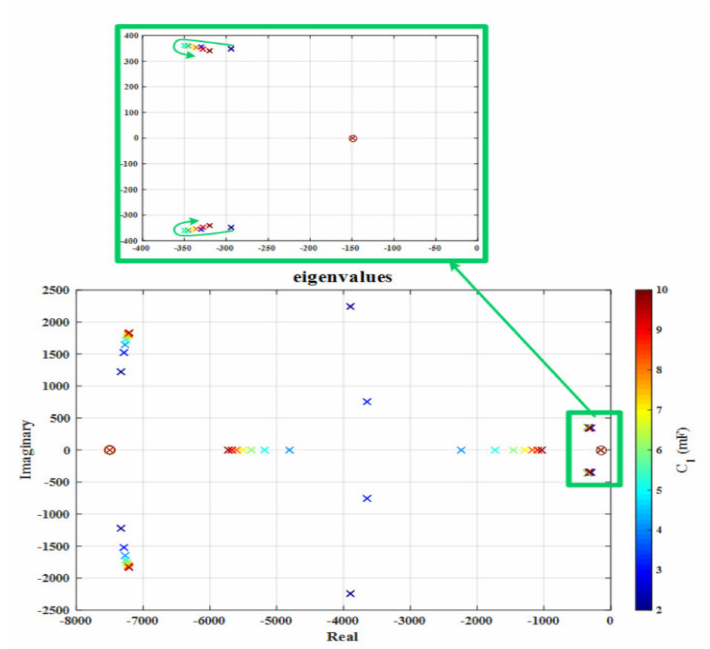
Figure 22. Dominant eigenvalues of the closed-loop system by changing the capacitance value of the first capacitor when the power of the first stack is equal to zero W and the other stacks inject the nominal power of 126 W.